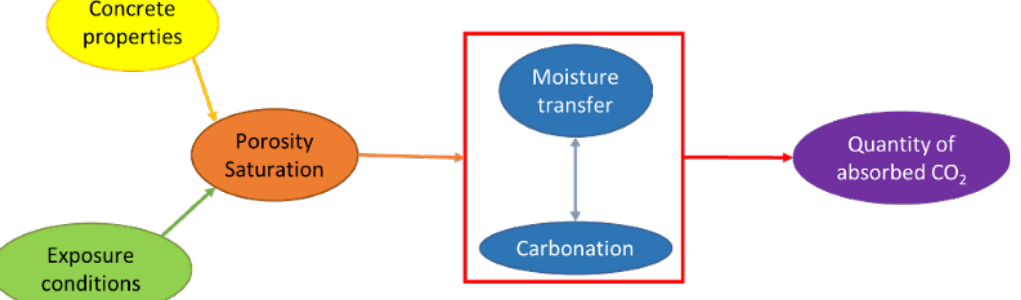
Figure 2. Schematic presentation of the SDReaM-crete model (only carbonation and hydric parts).